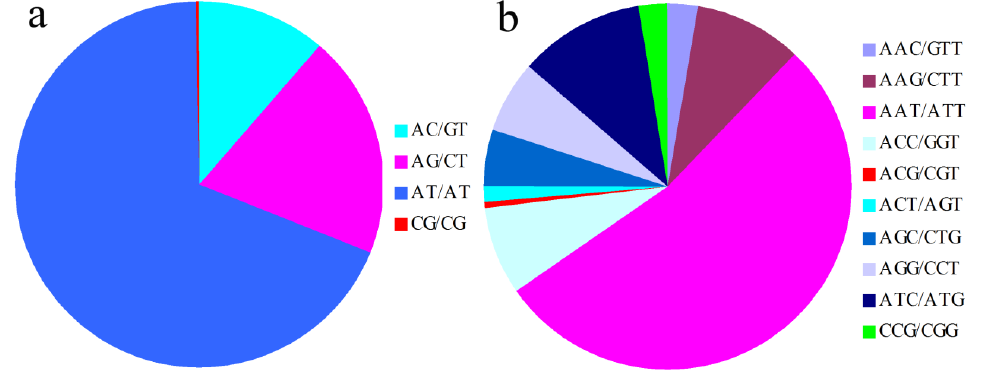
Figure 2. ( a ) Percentage of different dinucleotide repeat motifs in the sesame genome. and ( b ) Percentage of different motifs in trinucleotide repeat motifs in the sesame